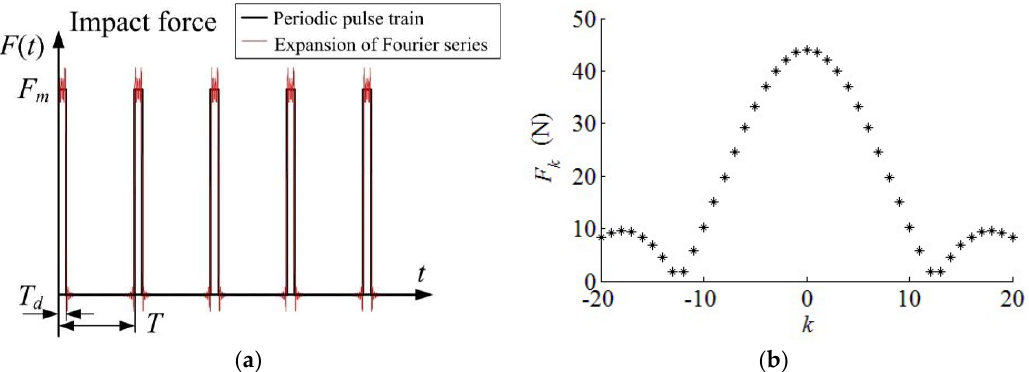
Figure 9. Periodic impact force: ( a ) time history; ( b ) Fourier coefficients